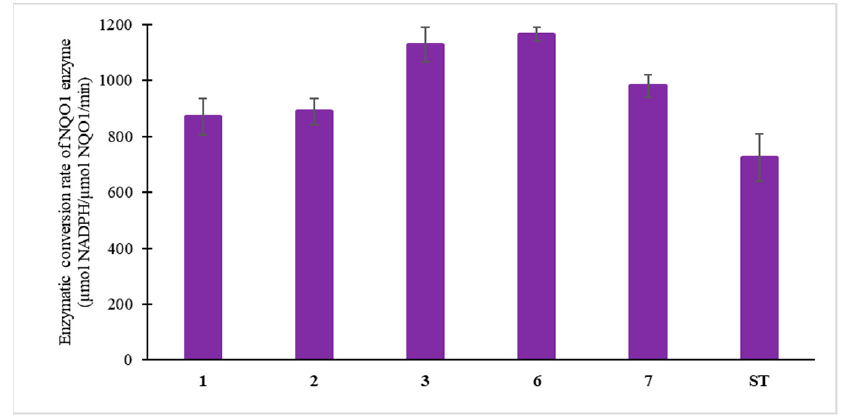
Figure 5. Enzymatic conversion rate of NQO1 of compounds 1–3 , 6–7 , and streptonigrin ( ST ). The derivatives 1–3 and 6–7 show a higher enzymatic conversion rate of the NQO1 protein than reference substance ( ST ), indicating that they are good substrates for NQO1.